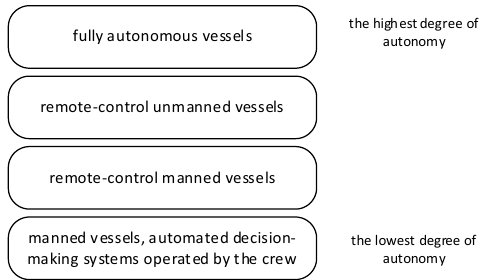
Figure 1. IMO classification of the autonomy of vessels.